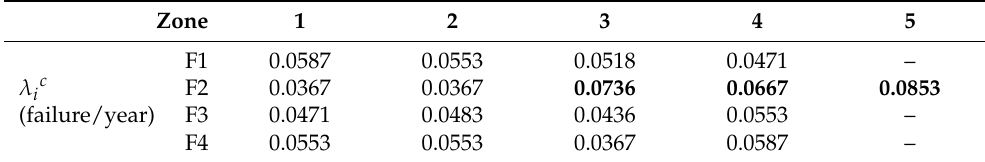
Table 4. Failure rates per zone obtained through the proposed method.